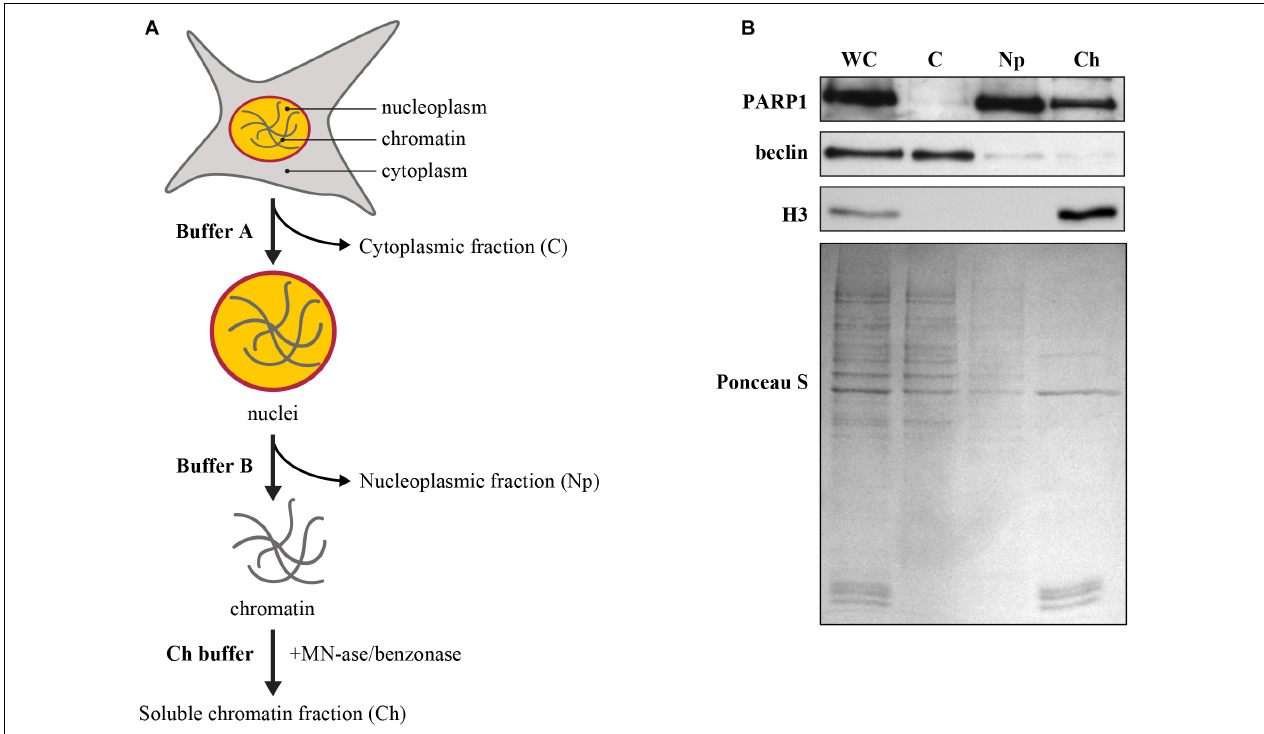
FIGURE 2 | (A) Flow-chart for subcellular fractionation. The harvested cells were suspended in appropriate buffer to prepare the whole cell or WC-extract, which was sequentially processed to isolate cytoplasmic or C-fraction (C) and nuclear fraction. The nuclear fraction was further processed to separate nucleoplasm or Np-fraction and chromatin-bound protein or Ch-fraction. The protocol and the buffer compositions are detailed in the main text. (B) Validation of subcellular fractionation. The proteins in whole cell (WC), cytoplasm (C), nucleoplasm (Np), and chromatin bound (Ch) protein fractions were resolved by SDS-PAGE, transferred to nitrocellulose membrane and probed for specific markers for each of the cellular compartments, such as PARP1 for entire nucleus (nucleoplasm and chromatin), histone H3 for chromatin alone, and beclin for cytoplasm. Ponceau S staining was used as loading control.